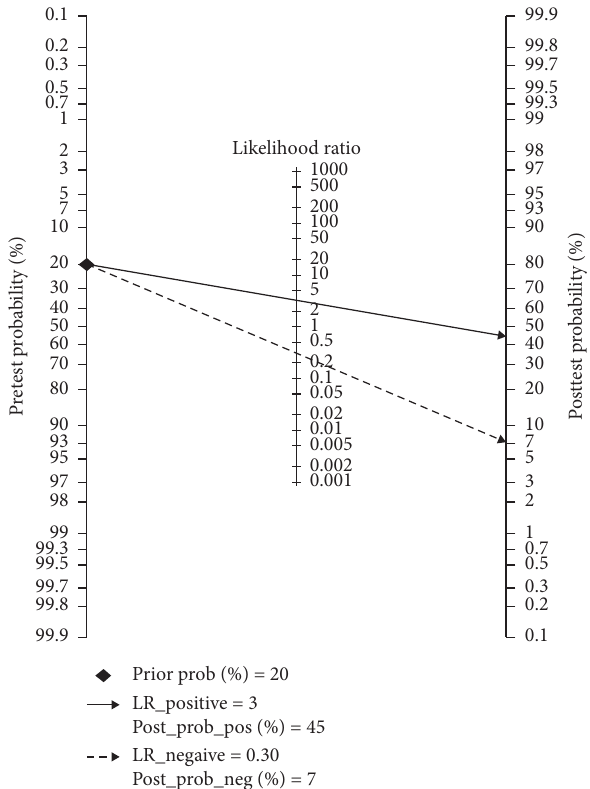
Figure 3: Fagan nomogram of the procalcitonin test for diagnosis of bacterial infection in liver failure patients.